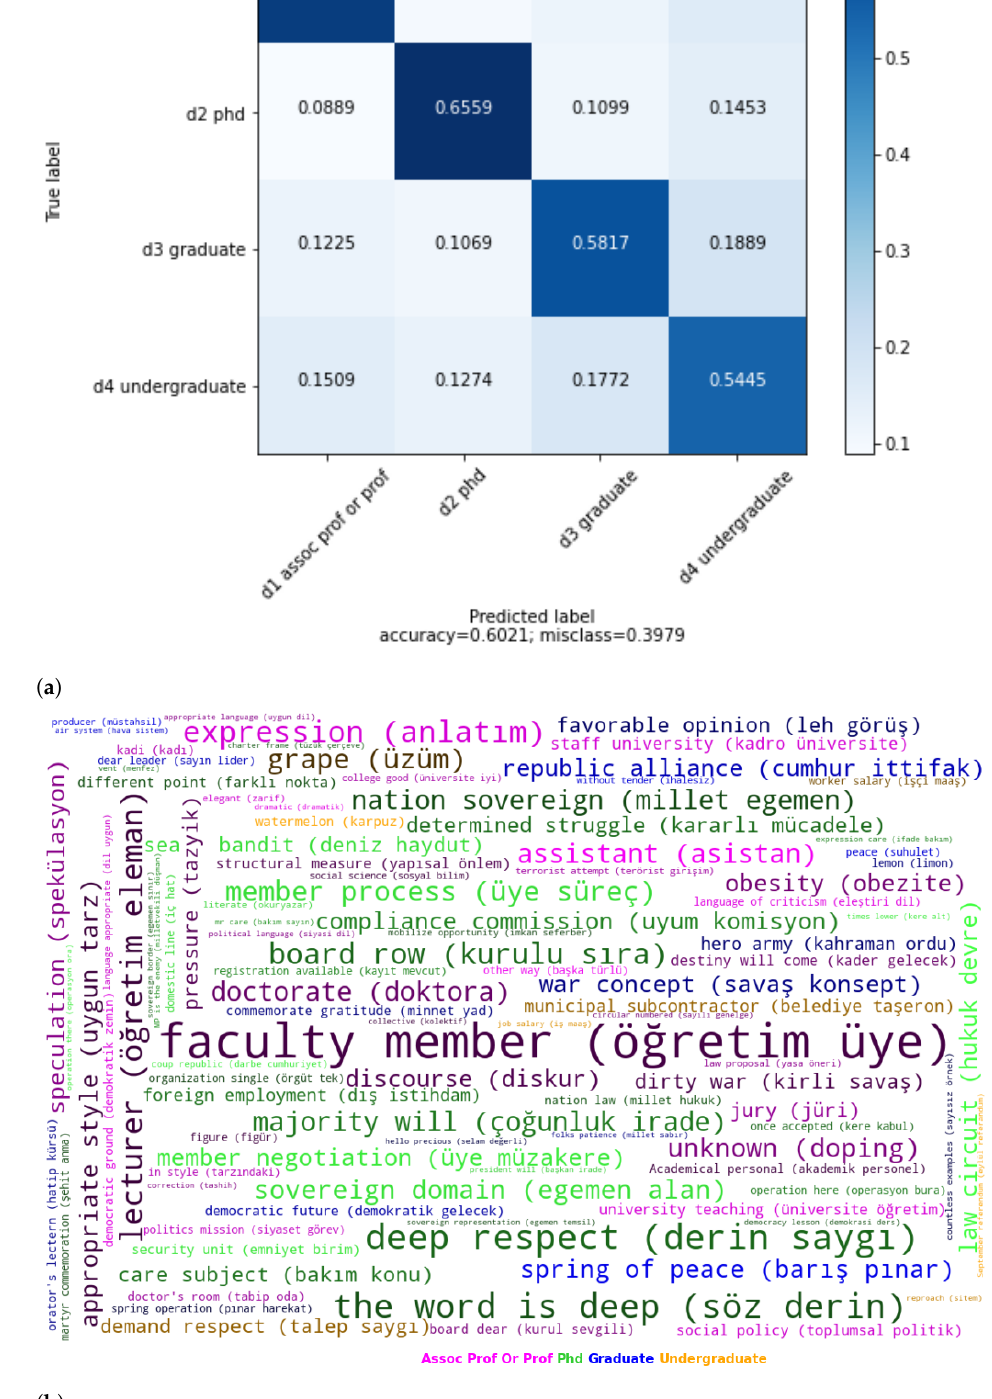
Figure 3. ( a ) Confusion matrix for education classification with TF-IDF (word) _LR. ( b ) Best terms of education trait of